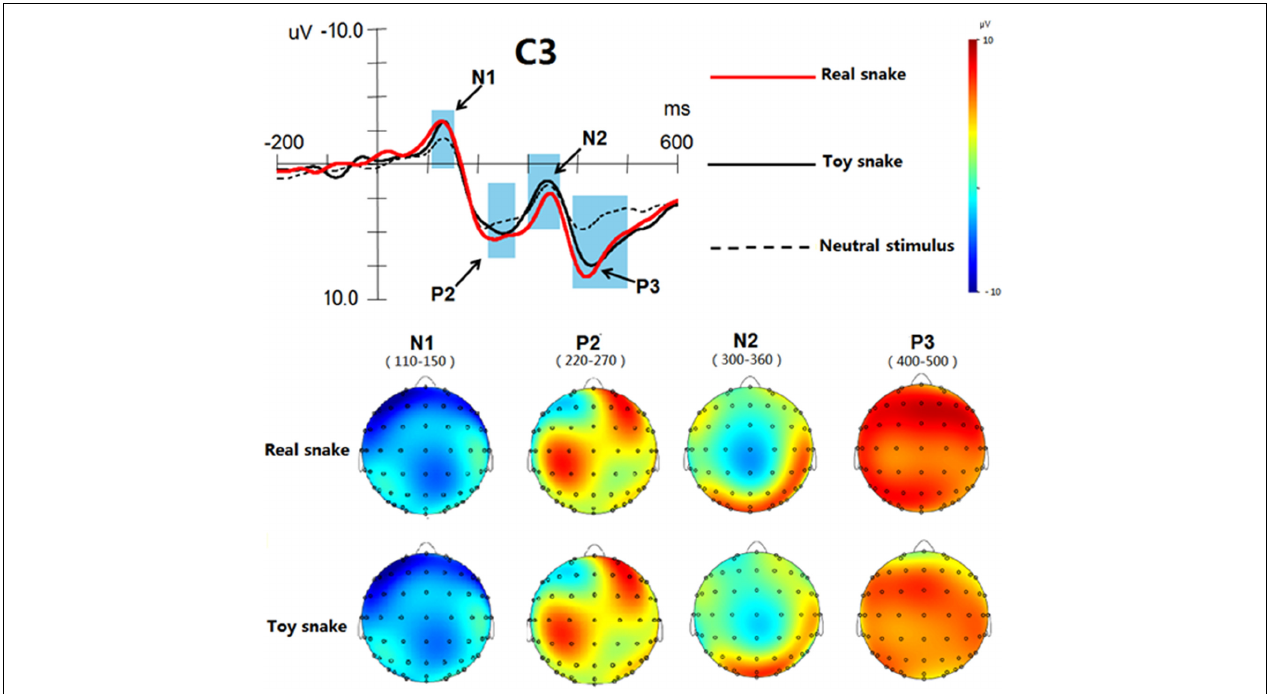
FIGURE 4 | Brain topographic maps of ERP components induced by real and toy